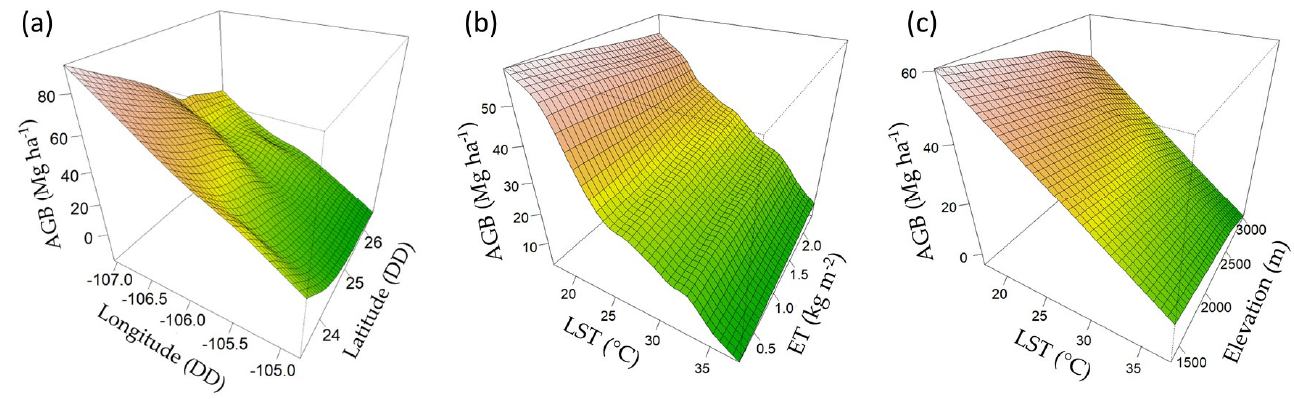
Figure 5. Responses of AGB to the interaction of two variables. ( a ) Latitude and Longitude, ( b ) Land surface temperature (LST) and evapotranspiration (ET) and ( c ) Land surface temperature (LST) and Elevation.